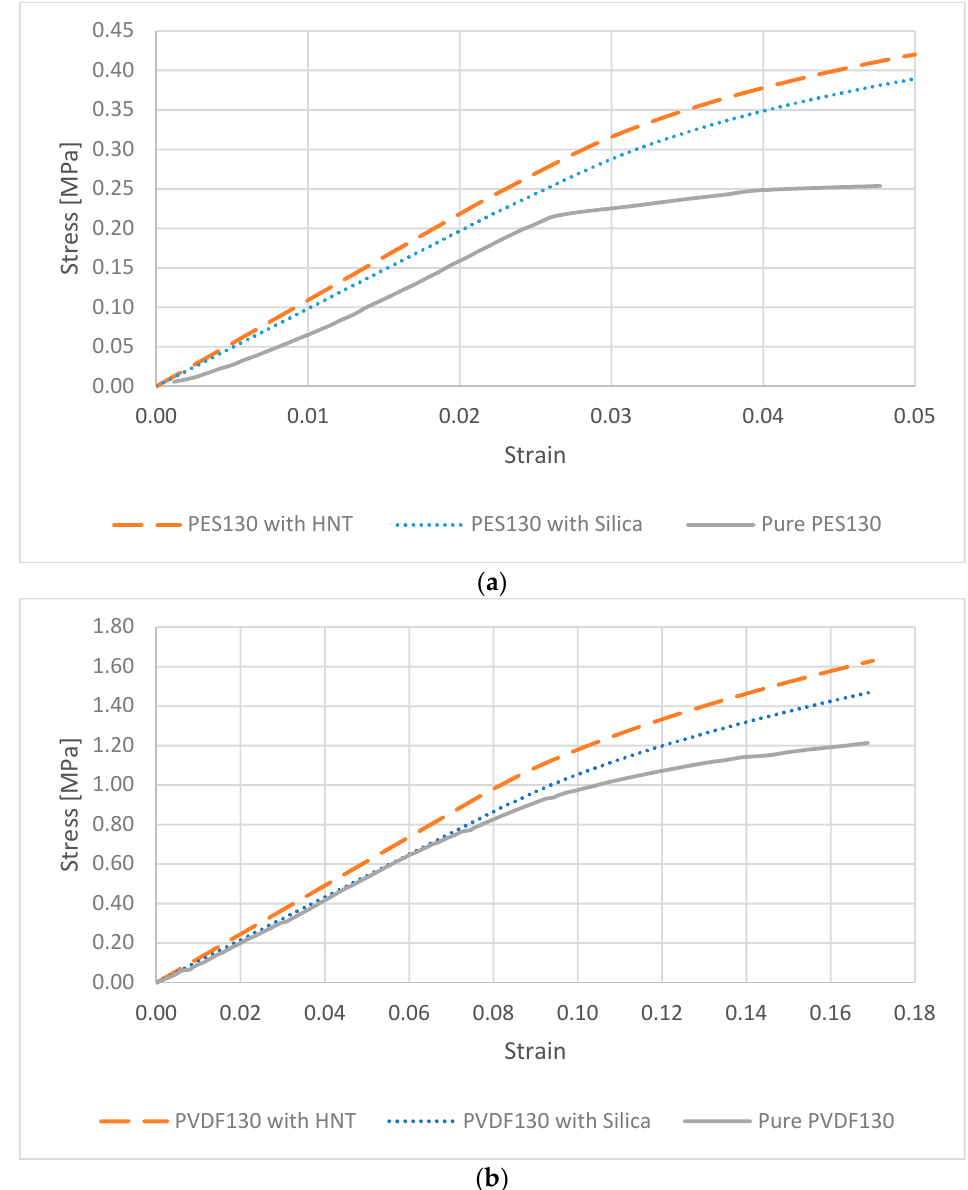
Figure 11. Stress-strain curves for the membranes ( a ) PES130 and its nanocomposites ( b ) PVDF130 and its nanocomposites.